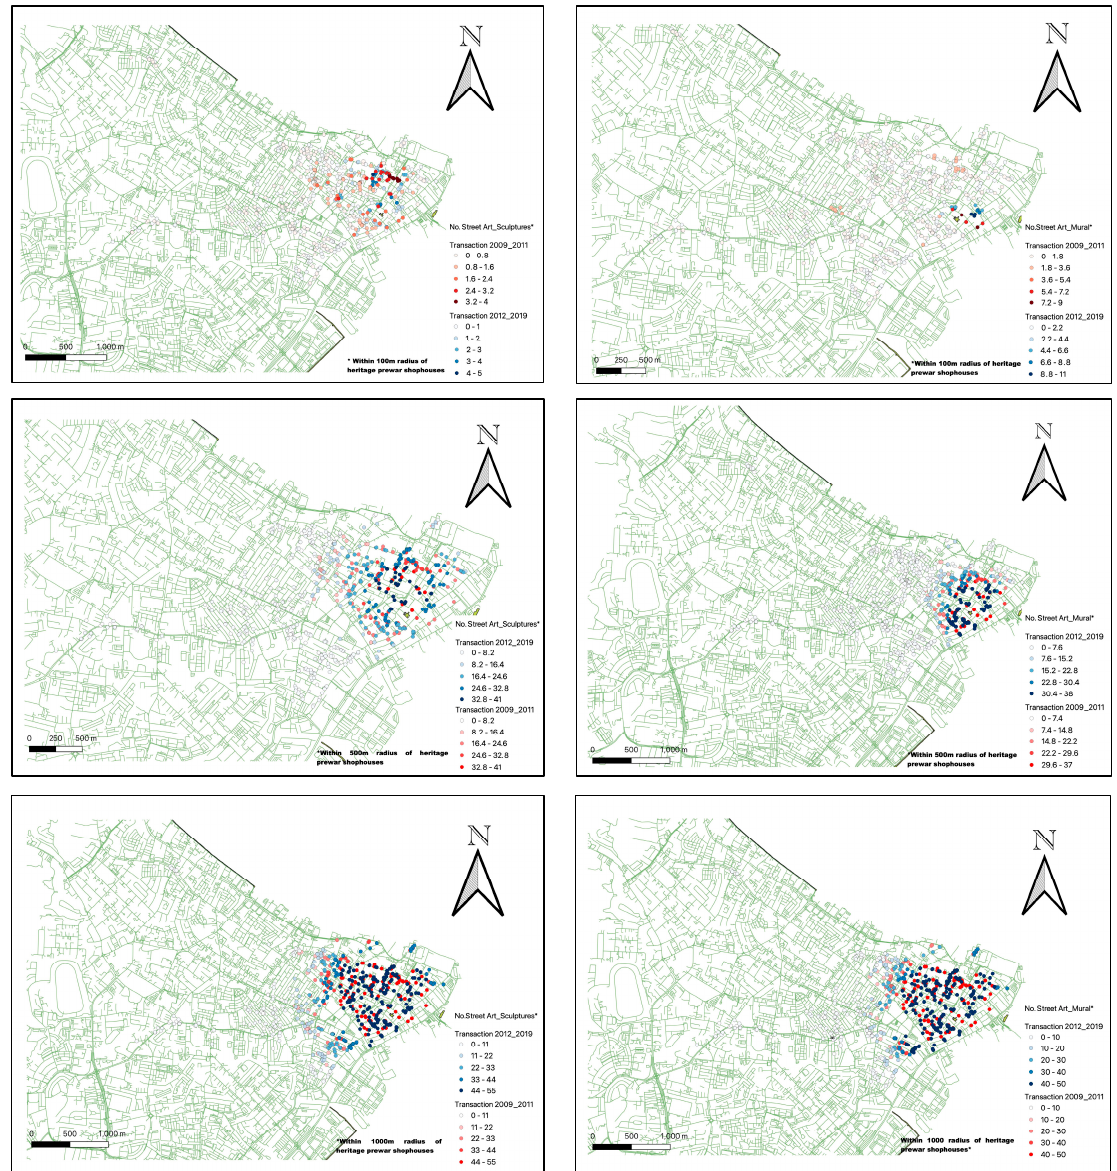
Figure 4. Number of Sculptures and Murals within 100 m, 500 m, and 1000 m radii of Heritage Prewar Shophouses. Table 1. List of Street Art in George Town, Penang.